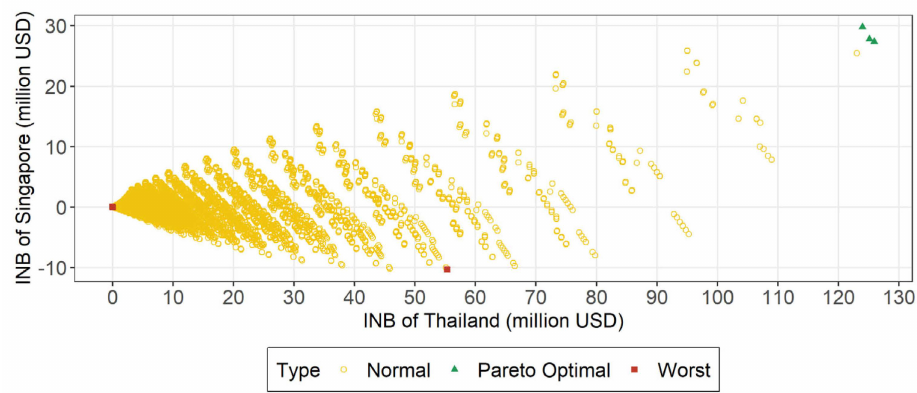
Figure 3. Incremental net benefit of Singapore and Thailand under all bilateral policy options, with Pareto optimal policies and worst policies highlighted. Abbreviations: SG, Singapore; TH, Thailand; INB, incremental net benefit; PO, Pareto optimal; m, million. Horizon: 1 month. Unit of INB for horizontal and vertical axes: million USD. Each hollow dot represents one bilateral policy option. The horizontal coordinate is the INB of TH and the vertical coordinate is the INB of SG. Three PO policy pairs are highlighted as triangle dots: (i) Both TH and SG do not require